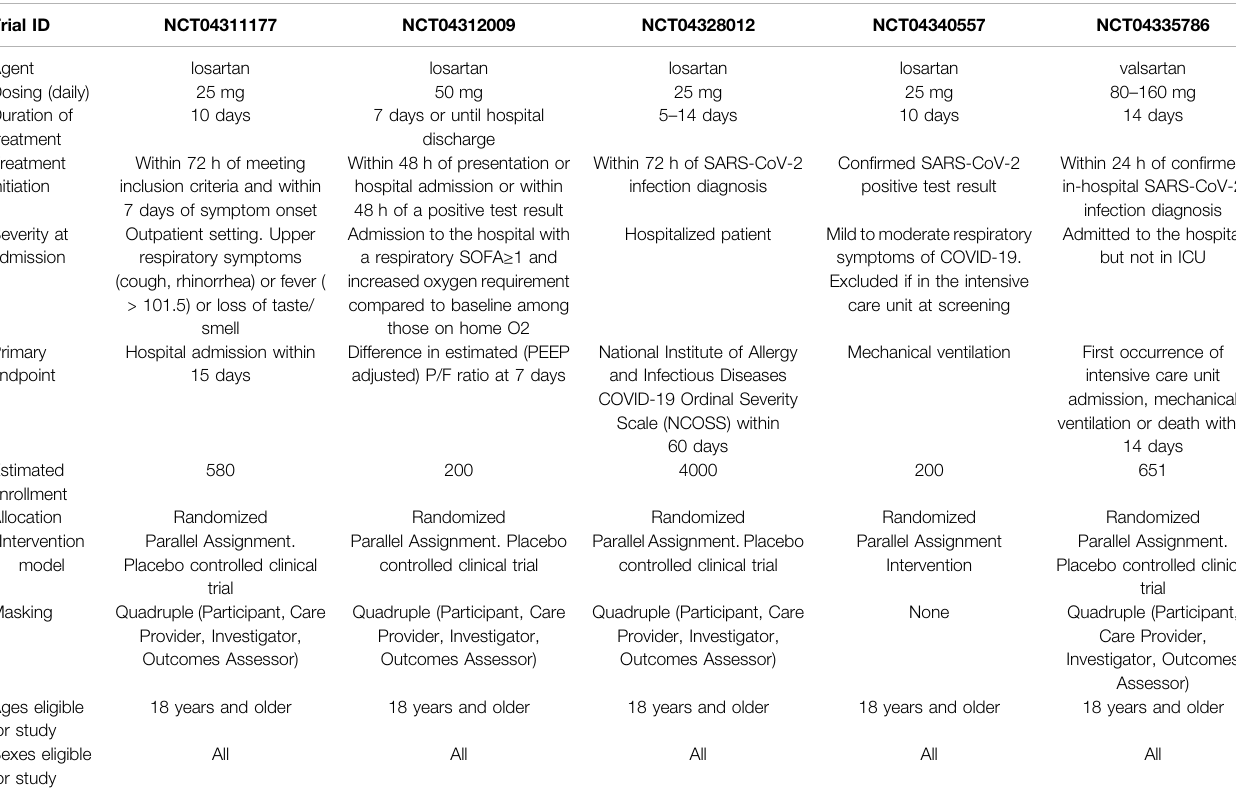
TABLE 1 | Main characteristics of losartan and valsartan prospective clinical trials on